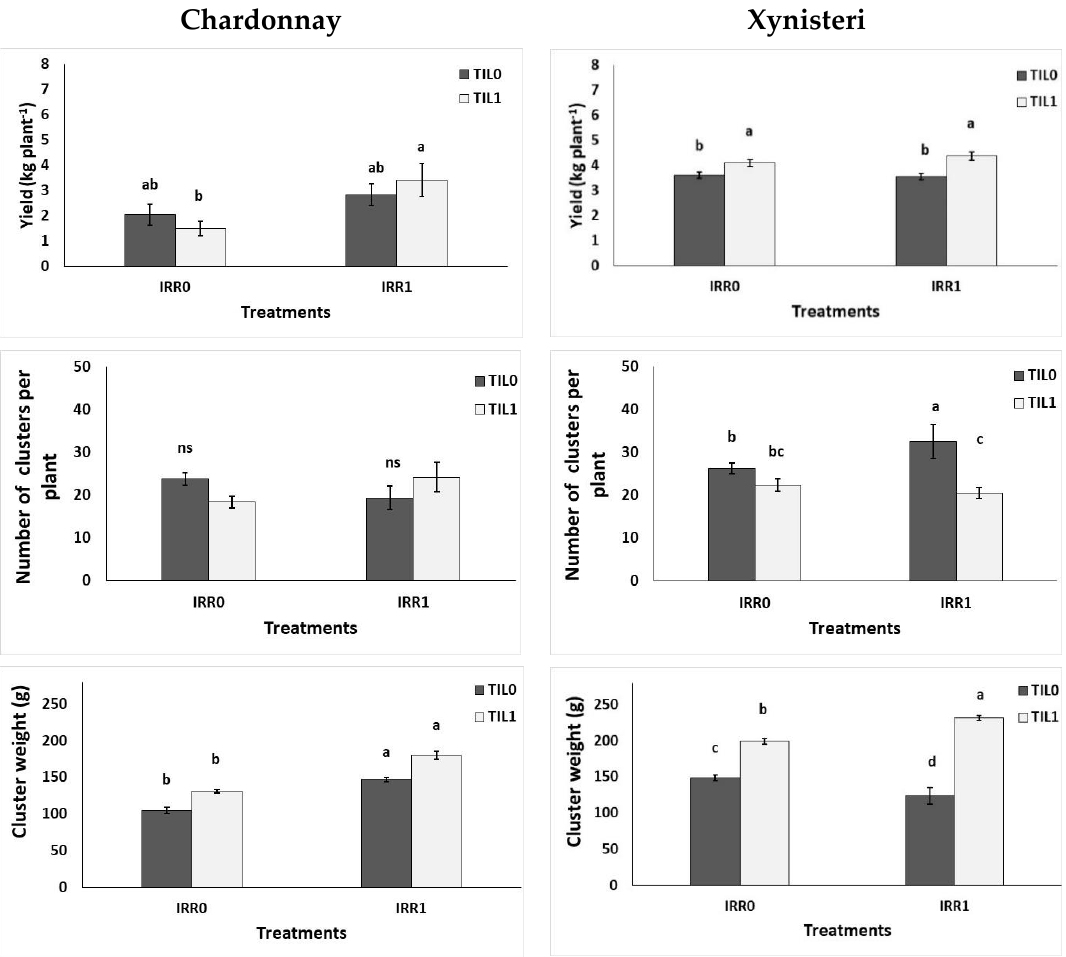
Figure 1. Effects of irrigation and tillage on the number of clusters per plant, cluster weight (g) and yield (kg plant −1 ). Significant differences ( p < 0.05) among treatments are indicated by different letters according to Duncan’s multiple range tests. Error bars show SE ( n = 4). ns: not significant.